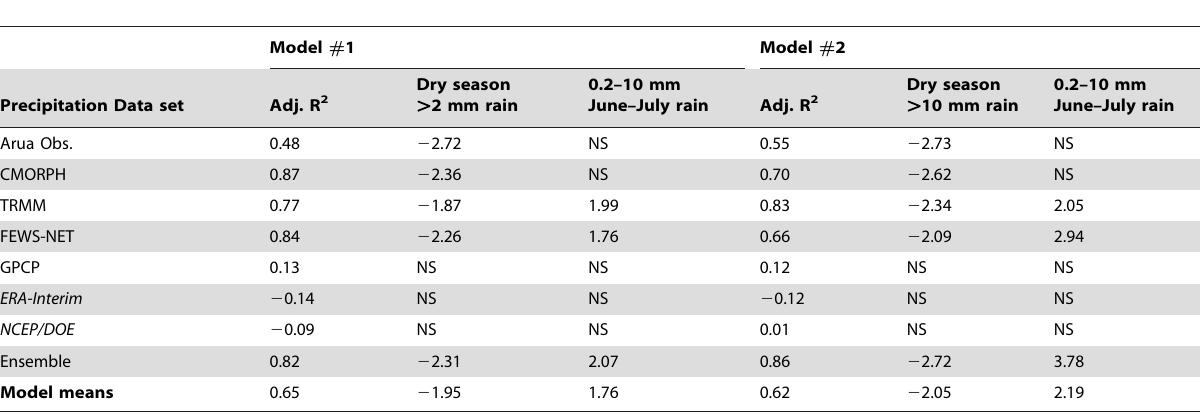
Table 3. Model adjusted r 2 values and coefficient estimates for the two consensus best-fit models when run using the meteorological ensemble dataset and each of the individual precipitation